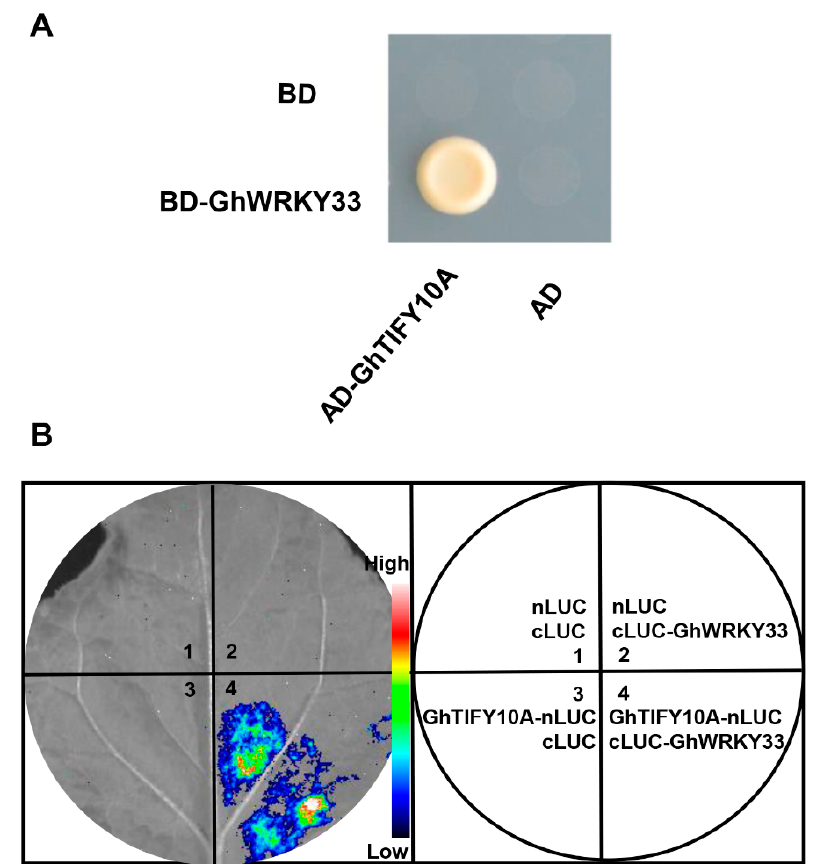
Figure 4. GhWRKY33 physically interacts with GhTIFY10A. ( A ) Yeast-two-hybrid assays. The interaction was indicated by the ability of cells to grow on a synthetic dropout medium lacking Leu/Trp/His/Ade.( B ) GhWRKY33 associates with GhTIFY10A in LCI assays. LUC images of N. benthamiana leaves coinfiltrated with various constructs are shown in the lower quadrant of the circle. The pseudocolor bar shows the range of luminescence intensity.